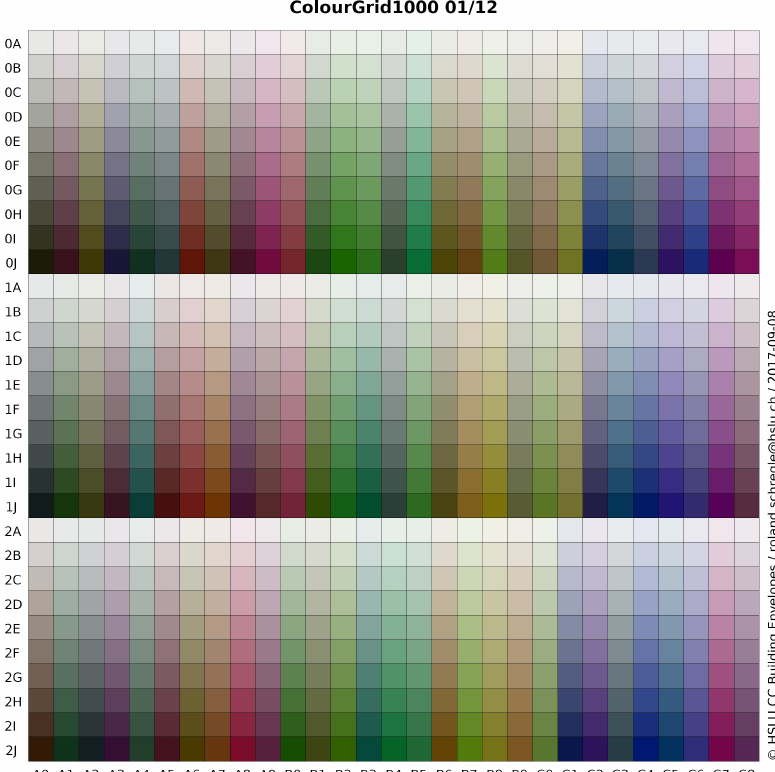
Figure 2. A sample grid of 29 × 30 nominal RGBA colours as generated by our script for printing on glass. Each column contains three unique hues whose print density is varied per row in 10% increments via the alpha channel. Each colour is indexed by a unique pair of X and Y